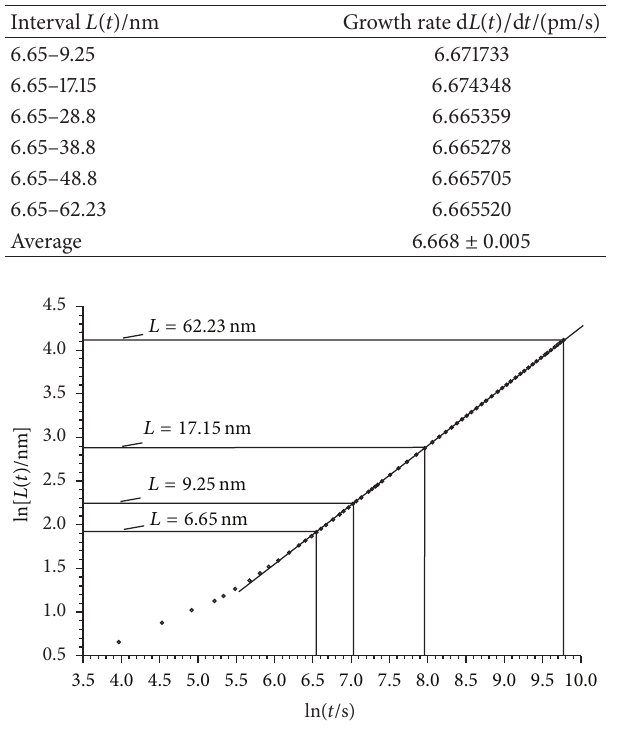
Figure 3: Oxide thickness ln [𝐿(𝑡)/ nm ] versus oxidation time ln (𝑡/ s ) relation for Blanc’s data set A8 (cp. Tables 1 and 2). The strong exponential behavior applies down to 6.65 nm (cp. Table 4).